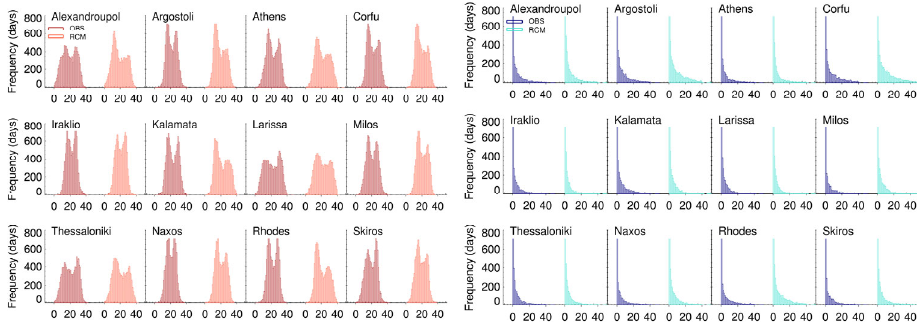
Figure 5. Histograms of maximum temperature observational (OBS, dark red) and model (RCM, light red) data, and precipitation (OBS, dark blue; RCM, light blue) for several Greek cities. Frequency corresponds to the number of days with temperature/precipitation values within certain classes (in °C and mm, respectively) over a 30 ‐ year period (1971–2000).